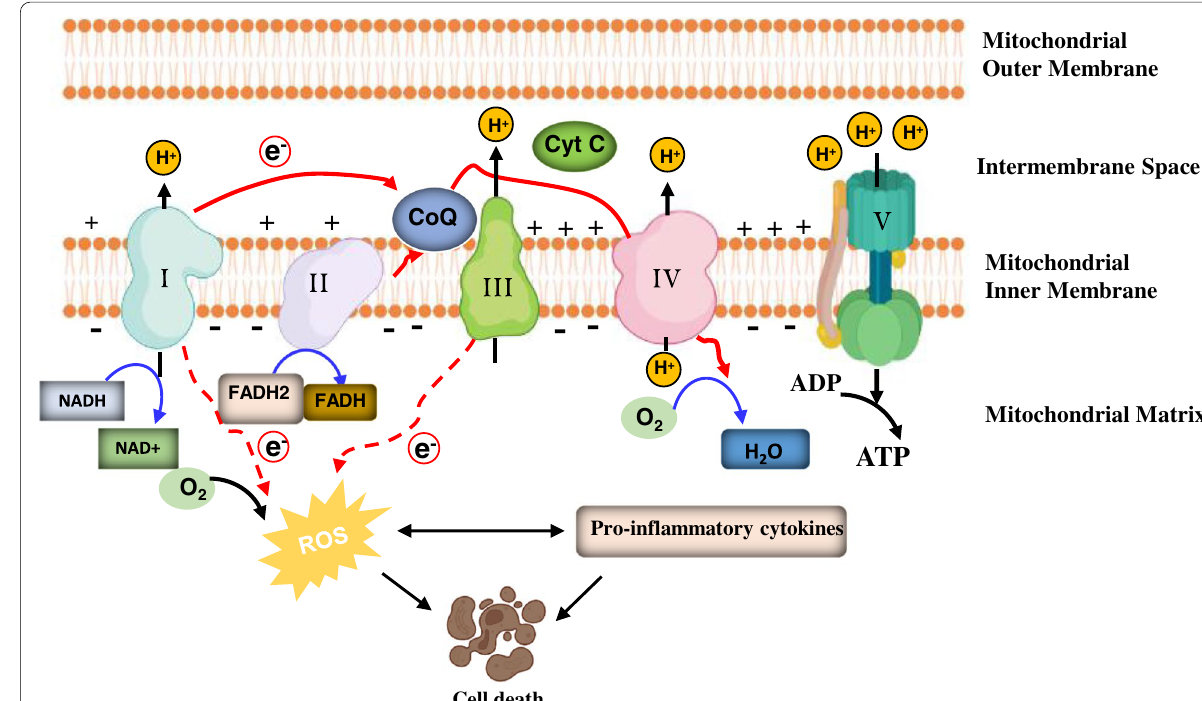
Fig. 4 Generation of reactive oxygen species (ROS) by the mitochondria. Under physiological conditions, a small number of electrons (dotted red line) leak out of the ETC and are transferred to oxygen to produce reactive oxygen species (ROS). However, in pathological situations, mitochondrial dysfunction and the impaired mitochondrial complex activity induce significantly increased ROS production. This leads to deleterious effects and a vicious cycle causing neuroinflammation, mitochondrial damage, energy depletion, neuronal damage, and cell